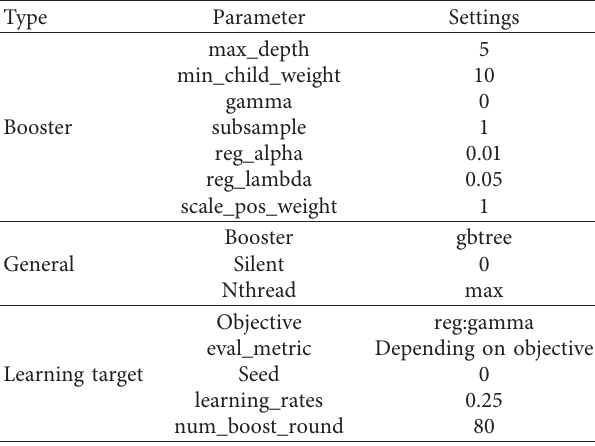
Table 3: Parameter settings of